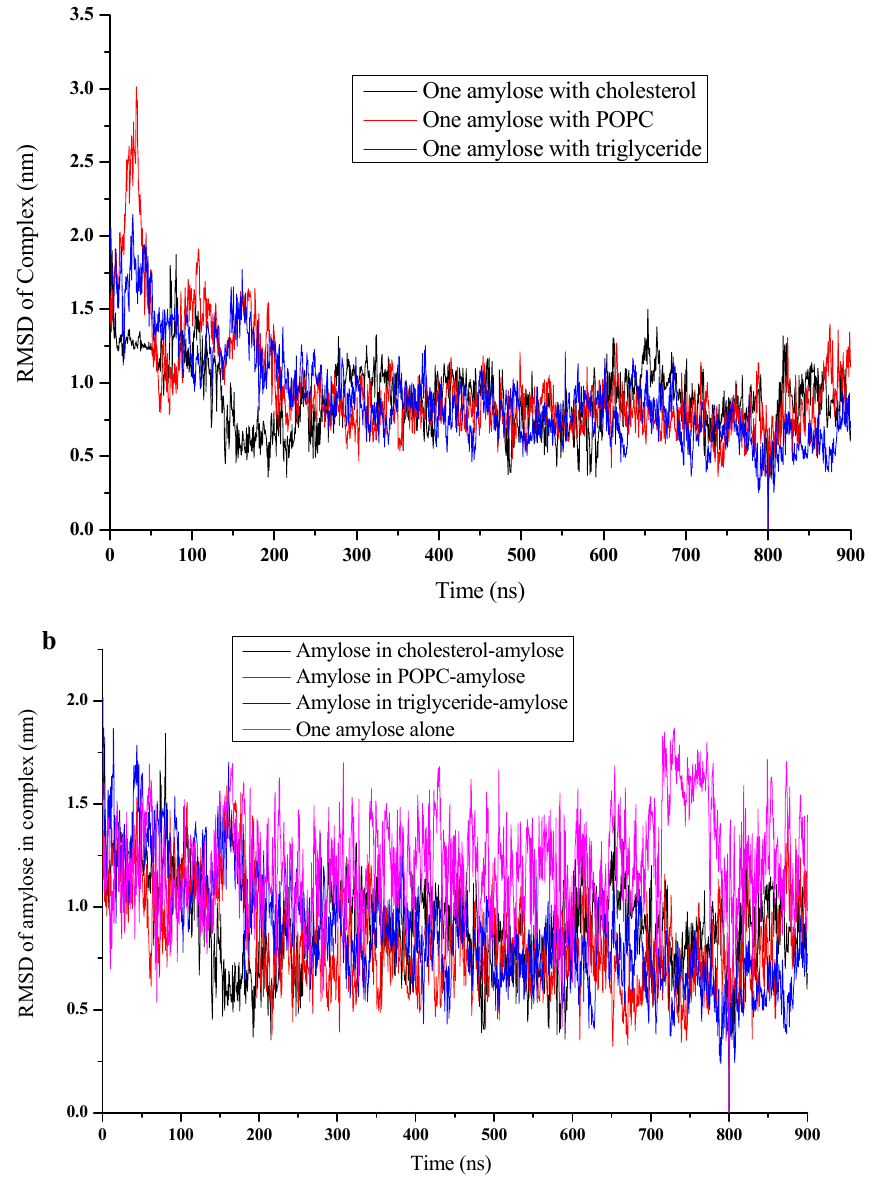
Figure 3. RMSD (nm) versus time (0 to 900 ns) for ( a ) complex of amylose-cholesterol (black), amylose-POPC (red) and amylose-triglyceride (blue); ( b ) for amylose in amylose-cholesterol complex (black), amylose-POPC complex (red), amylose-triglyceride complex (blue) and amylose alone (pink).